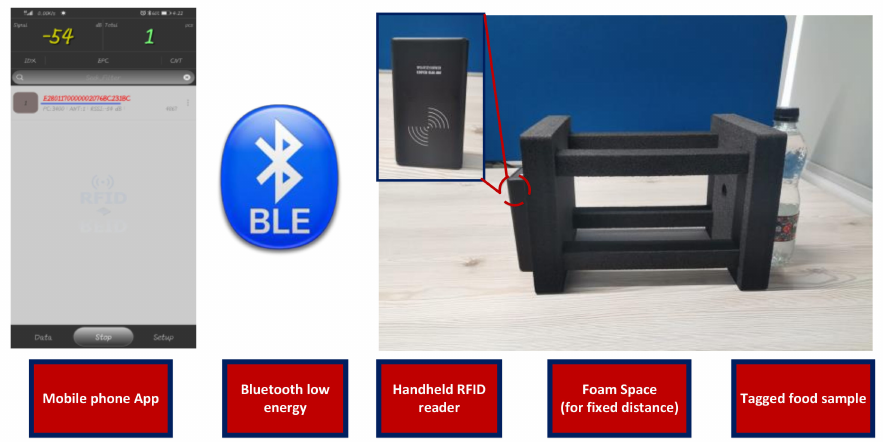
Figure 6. Handheld reader based setup connected with smart phone for food contamination